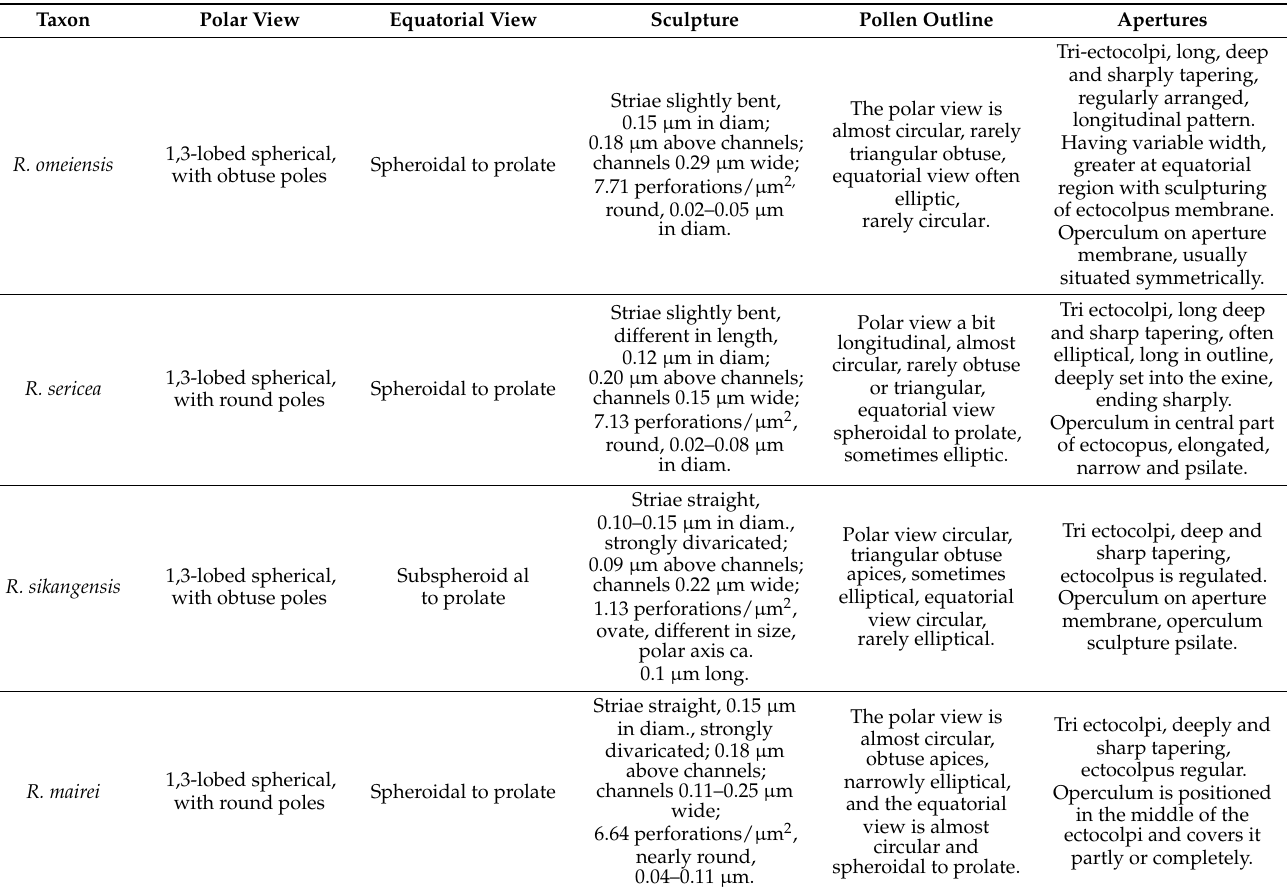
Table 2. Qualitative characteristics of pollen of R. sericea complex species.